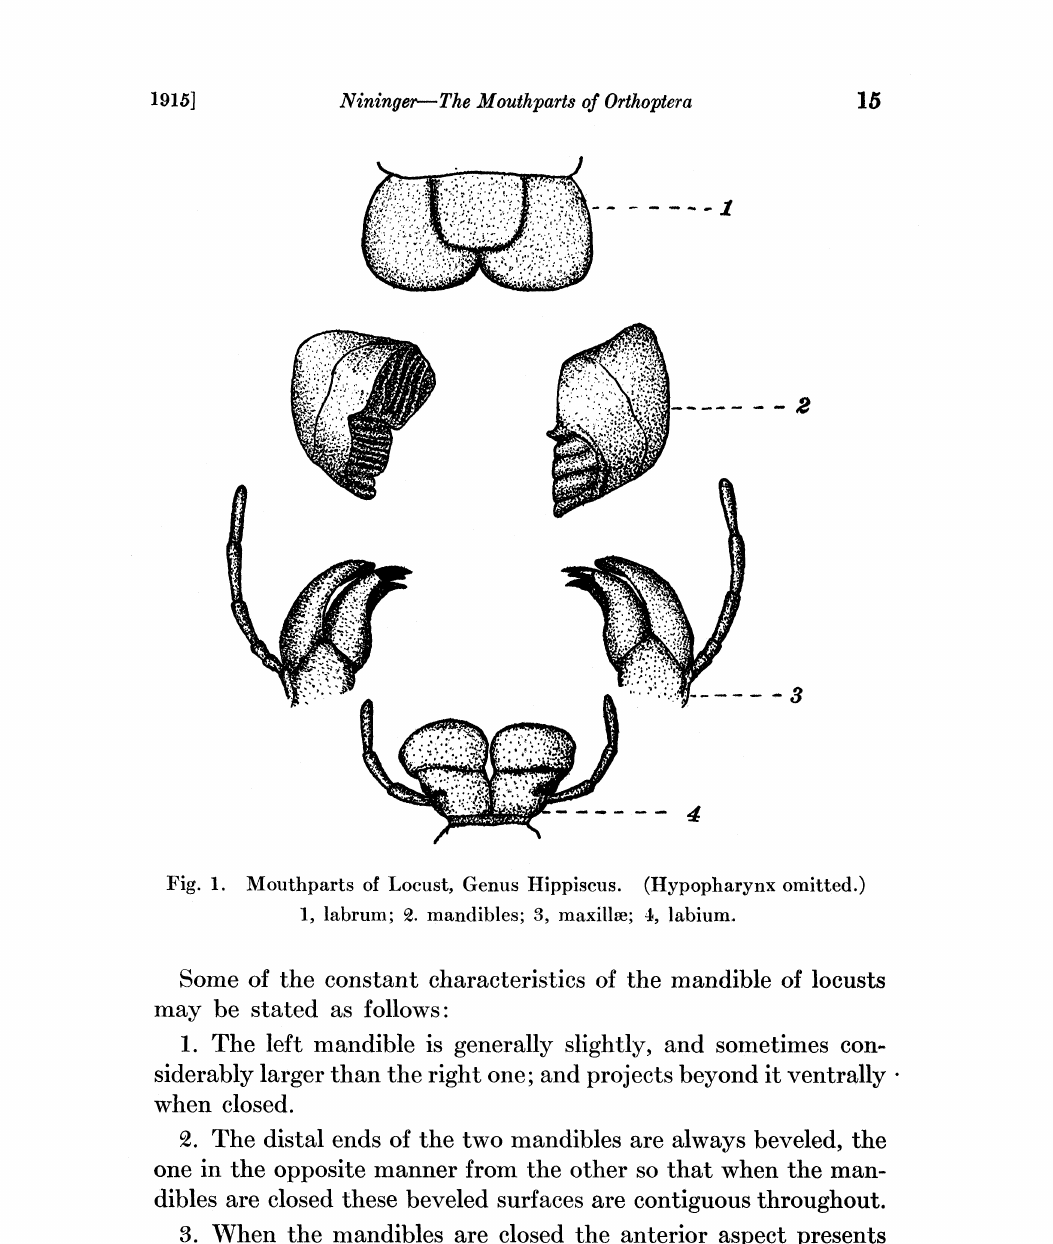
Fig. 1. Mouthparts of Locust, Genus Hippiscus. (Hypopharynx omitted.) 1, labrum; 2. mandibles; 3, maxillae; 4,